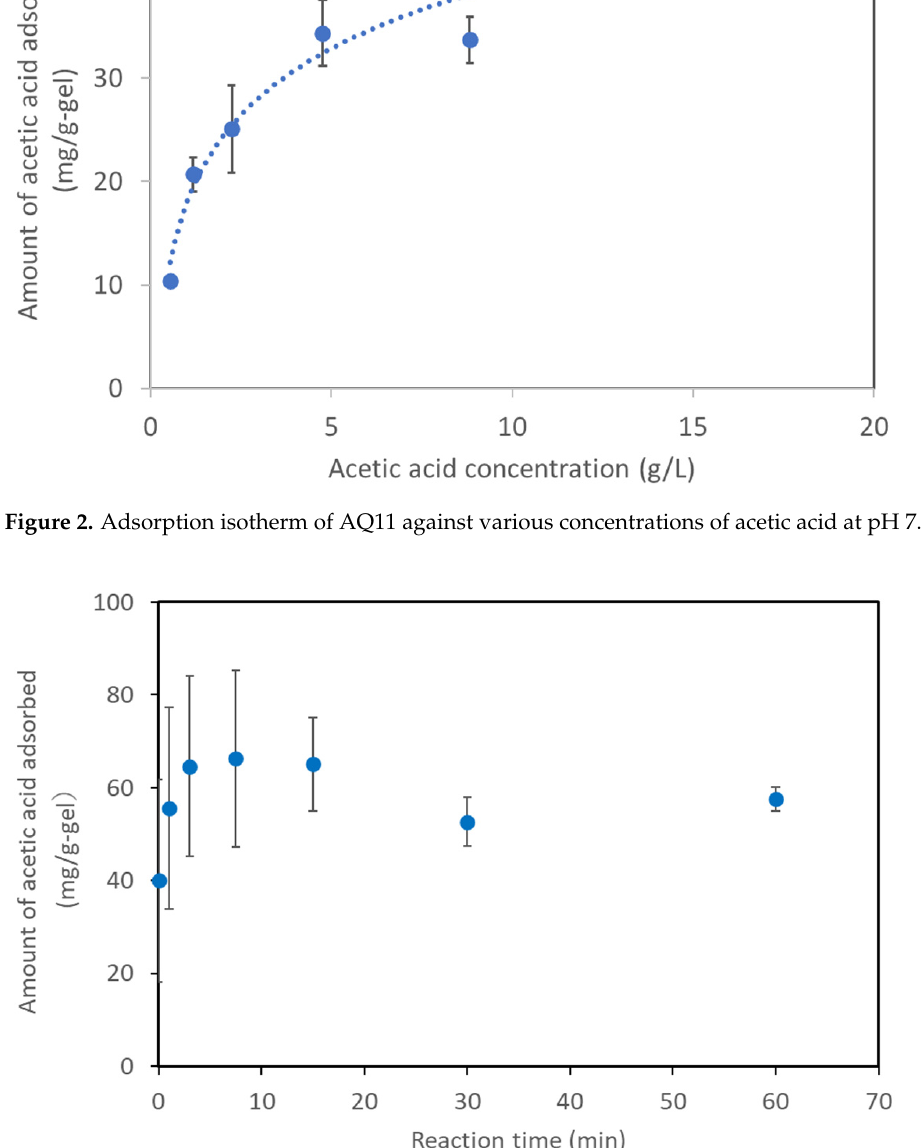
Figure 2. Adsorption isotherm of AQ11 against various concentrations of acetic acid at pH 7.0.